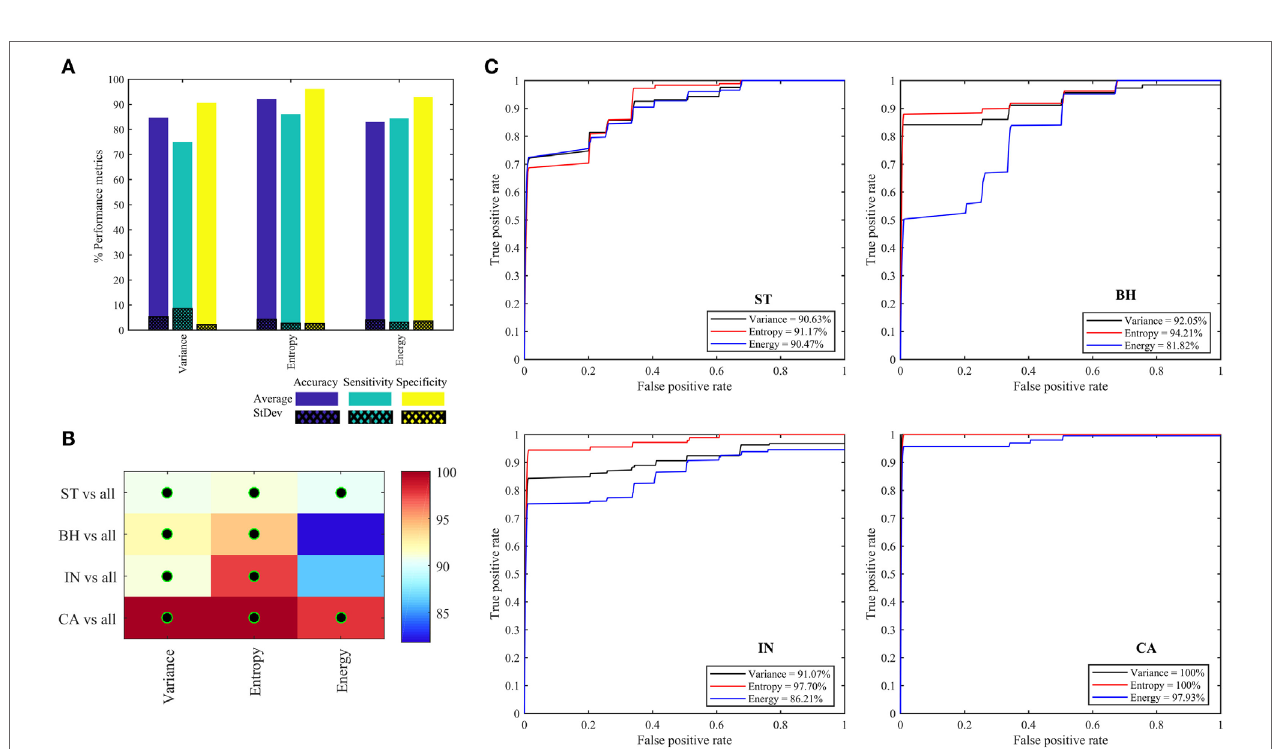
FigUre 7 | Performance metrics for classifying and predicting stroma, benign hyperplasia, intraepithelial neoplasia, and carcinoma using the features (variance, entropy, and energy) derived from combined eight oct-bands. (a) Classifier rate (accuracy, sensitivity, and specificity). (B) Heatmap of area under the curve (AUC) values for pathology tissue (PT) based on each feature, black–green circle represents the AUC value greater than 90%. (c) ROC curves from each PT type based on three quantifier functions (each quantifier generates eight